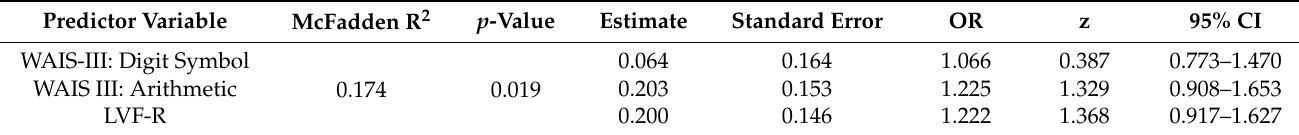
Table 3. Model of adherence to a CCT program “GRADIOR”.